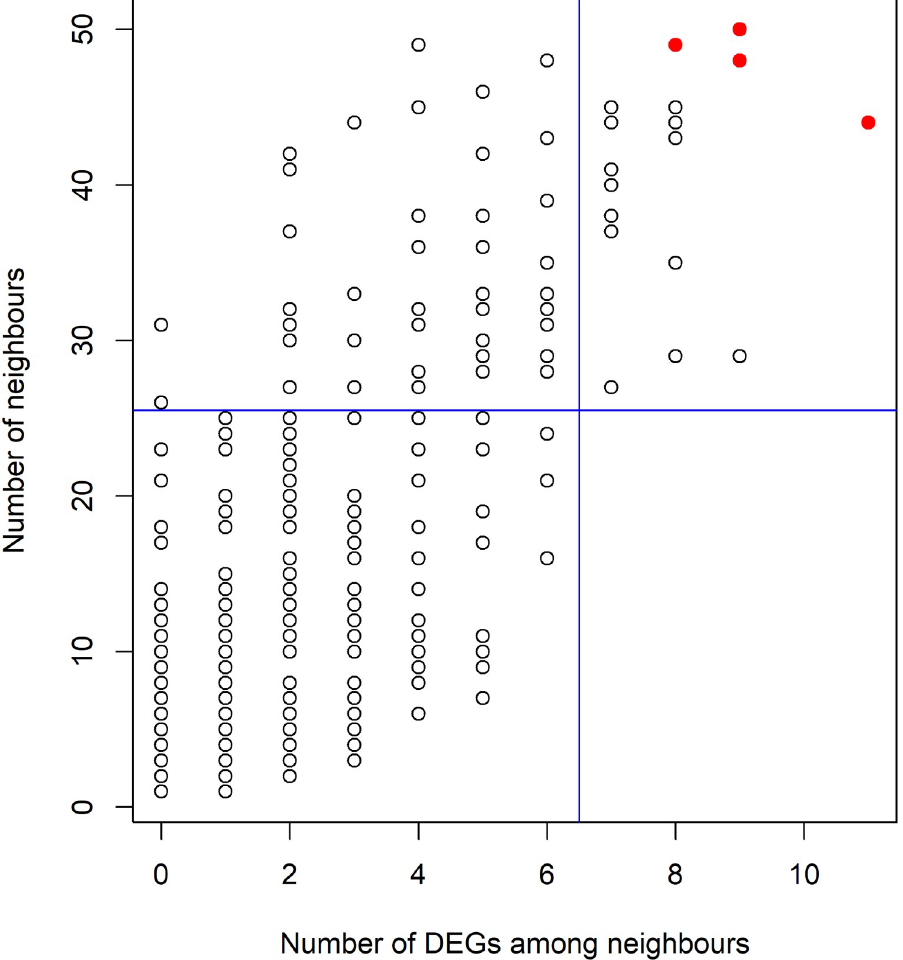
Fig 3. The scatterplot showing the relation between the number of neighbours and DEGs among them. The right top rectangle shows hub proteins with a high number of neighbours as well as DEGs among neighbours. The four circles represented in red colour correspond to NDUFS6, UQCR10, UQCRQ and NDUFV2.